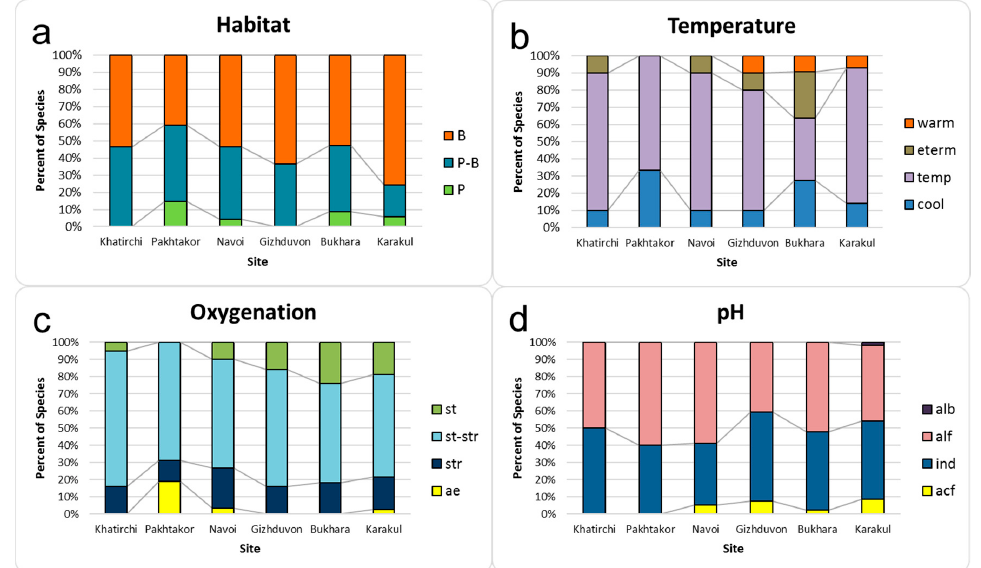
Figure 4. Distribution of bioindicators of habitat preferences, temperature, oxygenation, and pH in the Zarafshan River, 2009–2015. Abbreviation for ecological indicator groups: ( a ), Habitat preferences (Hab): B, benthic; P-B, planktonic-benthic; P, planktonic. ( b ), Water temperature (T): cool, cool-loving species; temp, temperate temperature water inhabitants; eterm, eurythermic species, warm, warm water inhabitants. ( c ), Streaming and Oxygenation (Oxy): aer, aerophiles, str, streaming waters inhabitant; st-str, low streaming waters inhabitant; st, standing water inhabitant. ( d ), Water pH (pH): acf, acidophilic species; ind, indifferent; alf, alkaliphilic species; alb, alkalibiontes.